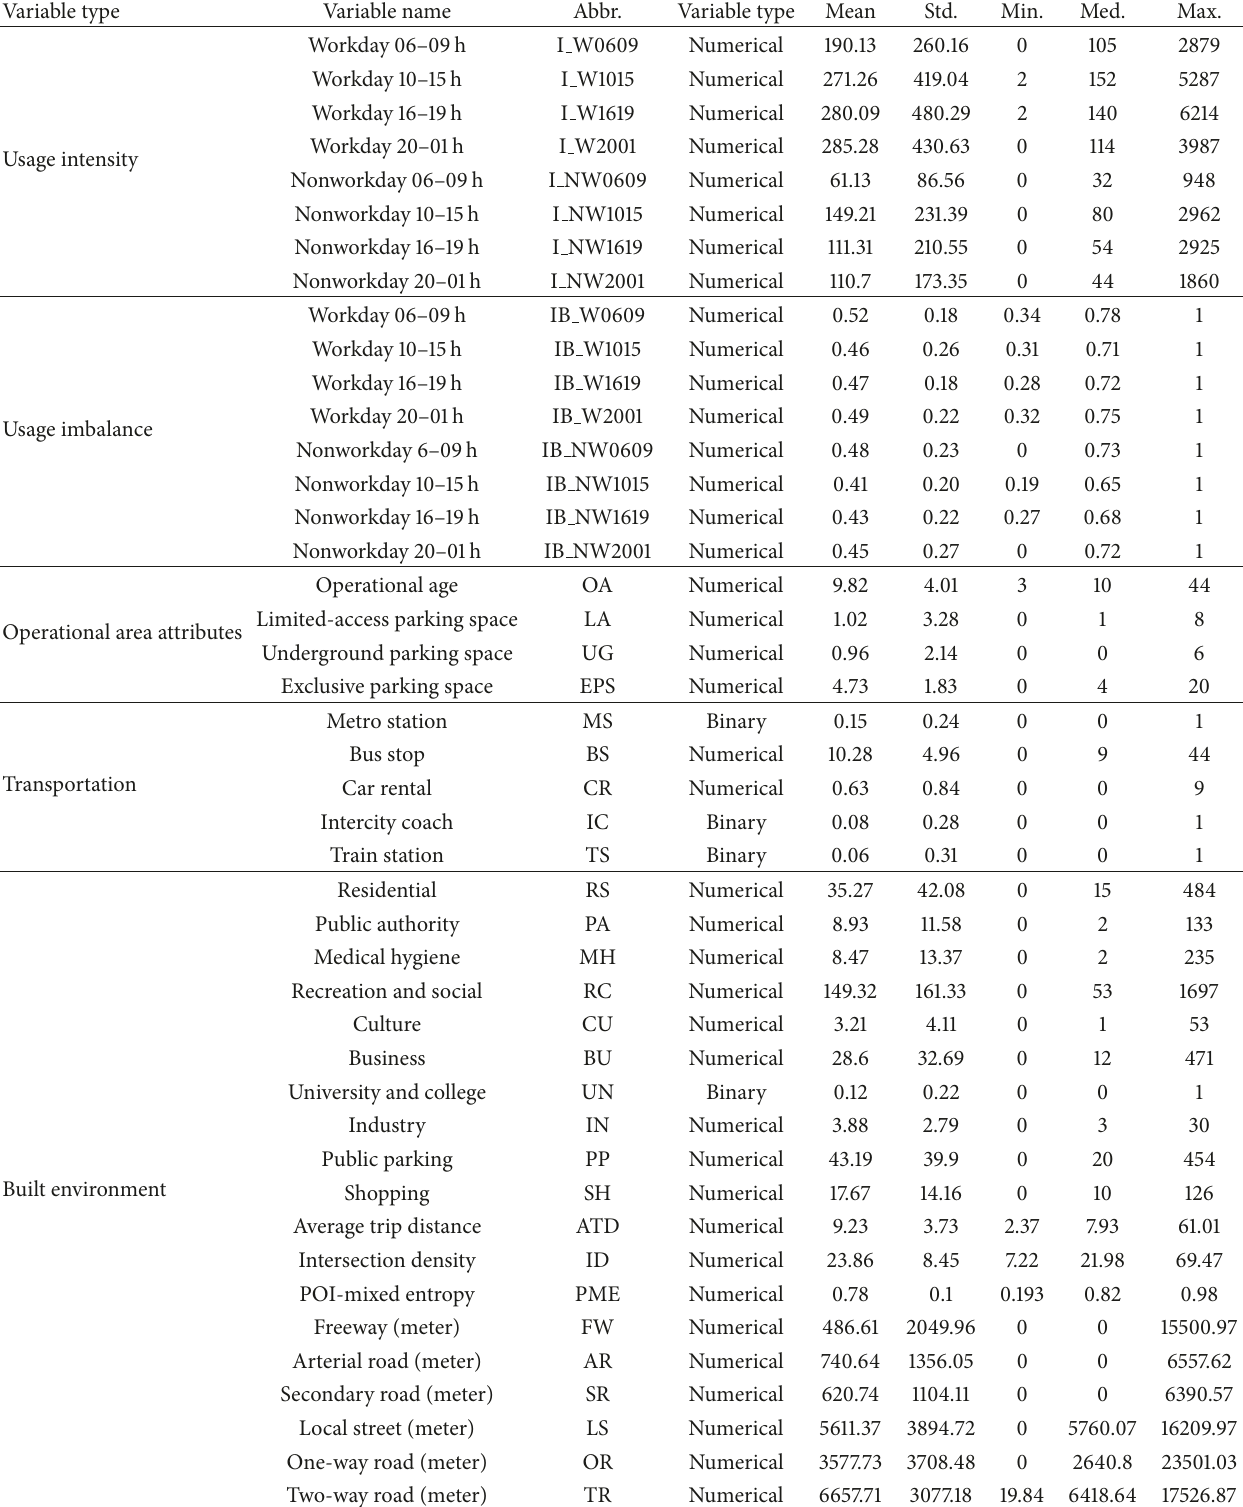
Table 2: Descriptive statistics of